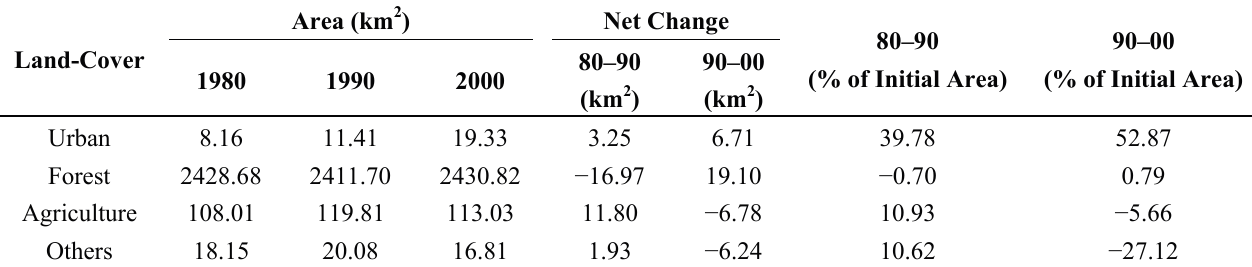
Table 2. Land-use changes between 1980 and